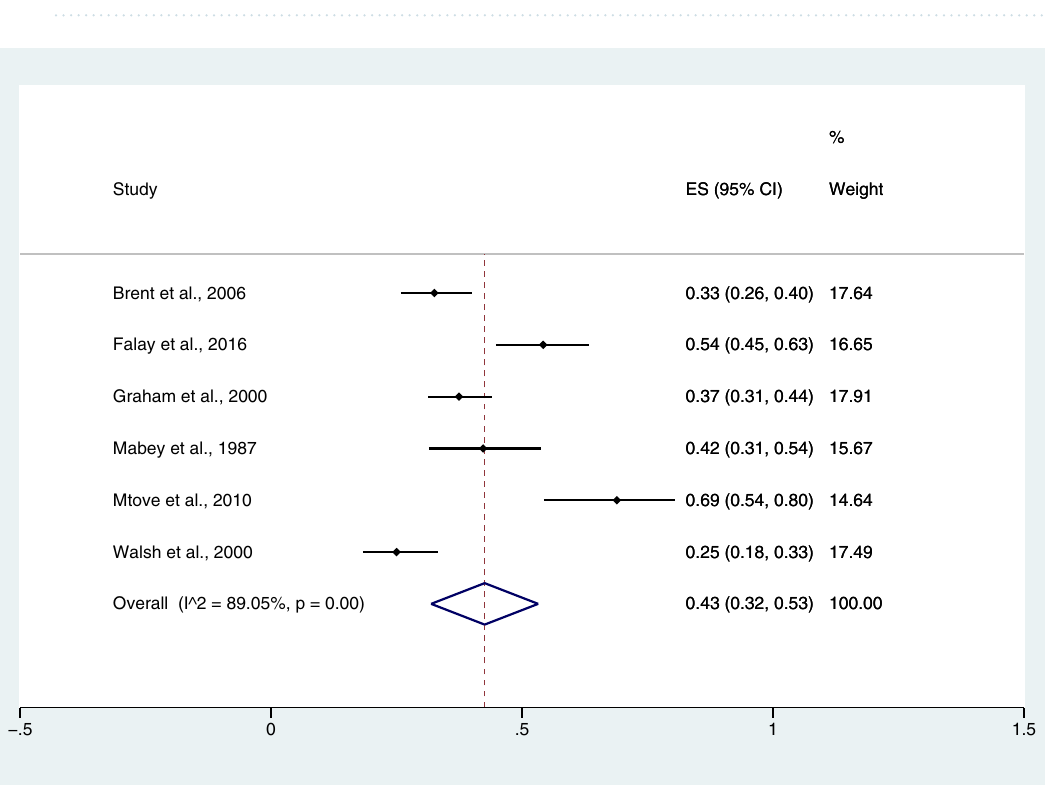
Figure 22. Pooled prevalence of malaria infection among patients with typhoidal Salmonella spp. ES proportion estimate (multiply 100 units for interpreted as prevalence estimate), CI confidence interval.